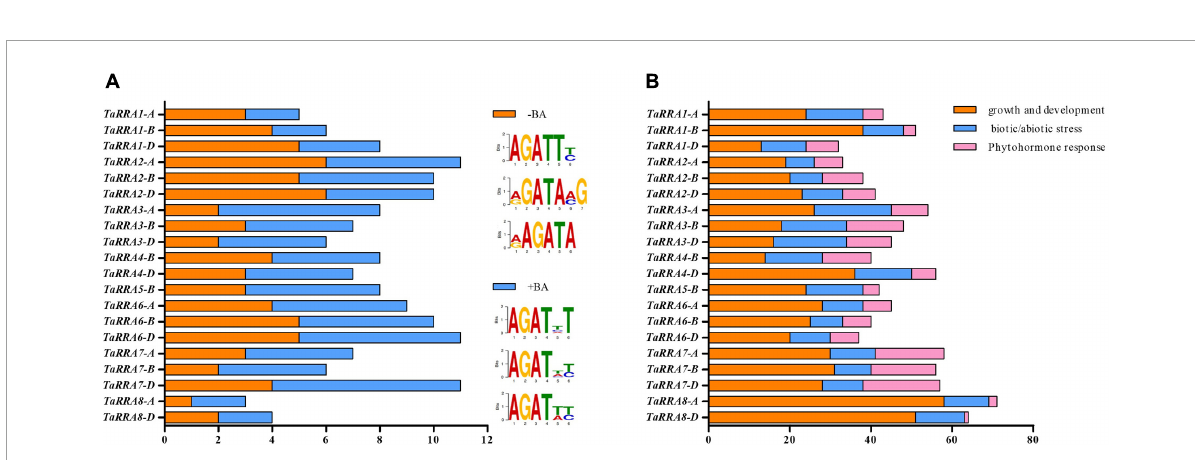
FIGURE5 Prediction of cis -acting elements in the promoter region of TaRRAs. (A) BA-dependent (+BA) and BA-independent (-BA) RRB binding cis -acting elements in the promoter of TaRRAs . (B) Growth and development, biotic/abiotic stress, and phytohormone responses cis -acting elements in the promoter of TaRRAs